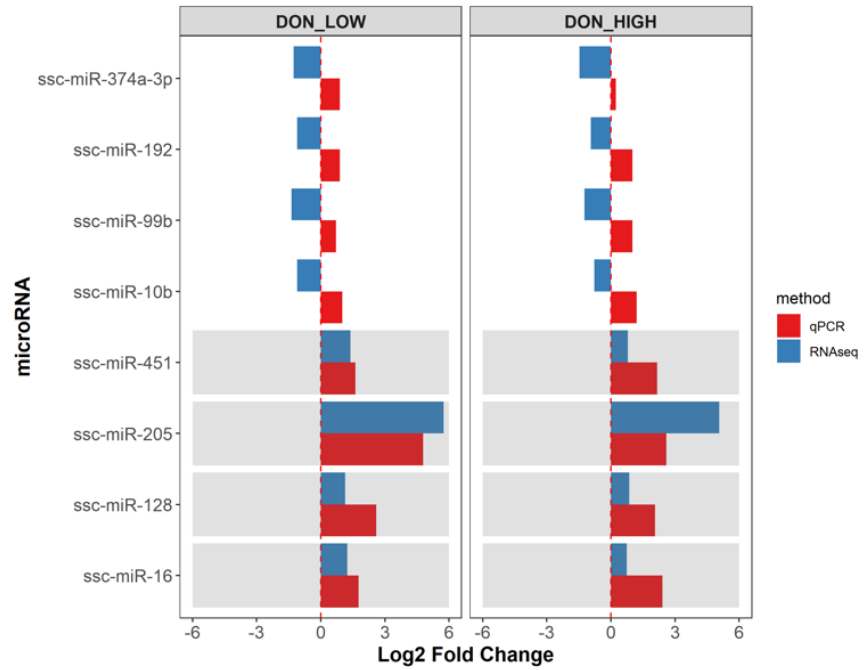
Figure 4. Comparison of microRNA expression in the serum based on qPCR and sequencing data. Log2 fold changes of in the DON_LOW (left) and DON_HIGH (right) compared to the Control group assessed via small RNA sequencing (blue) and qPCR (red).